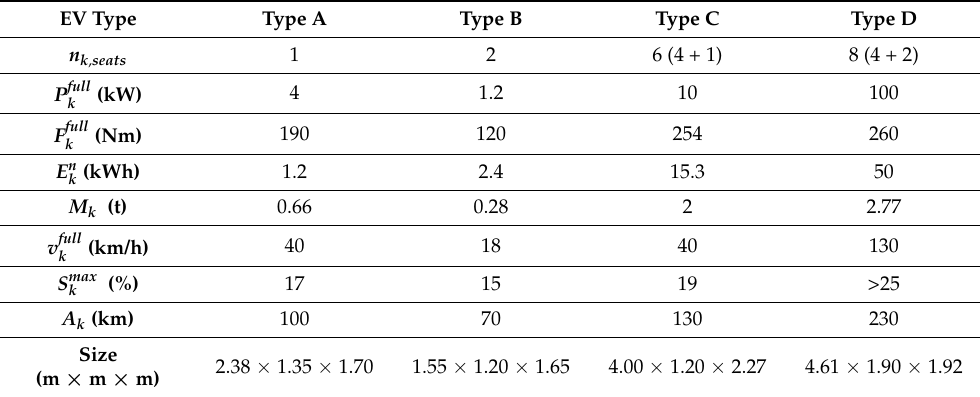
Table 1. Main technical and mechanical characteristics of the simulated EVs.